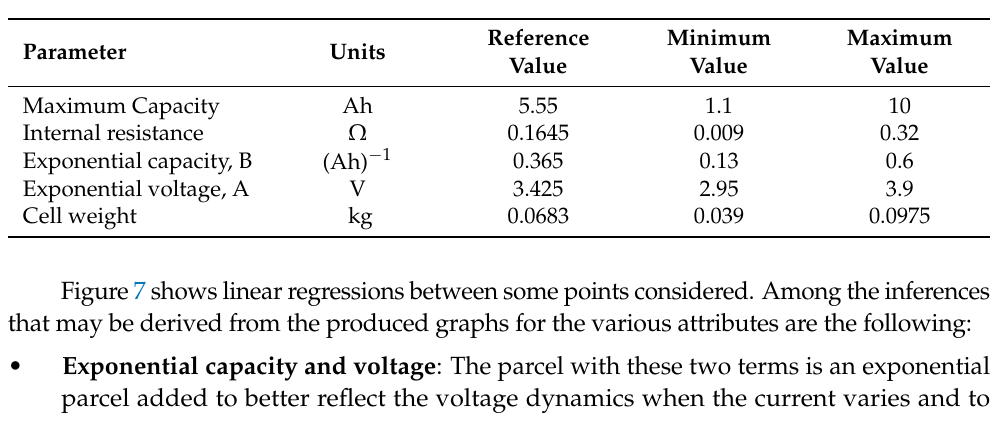
Table 7. Parameter variations for sensitivity